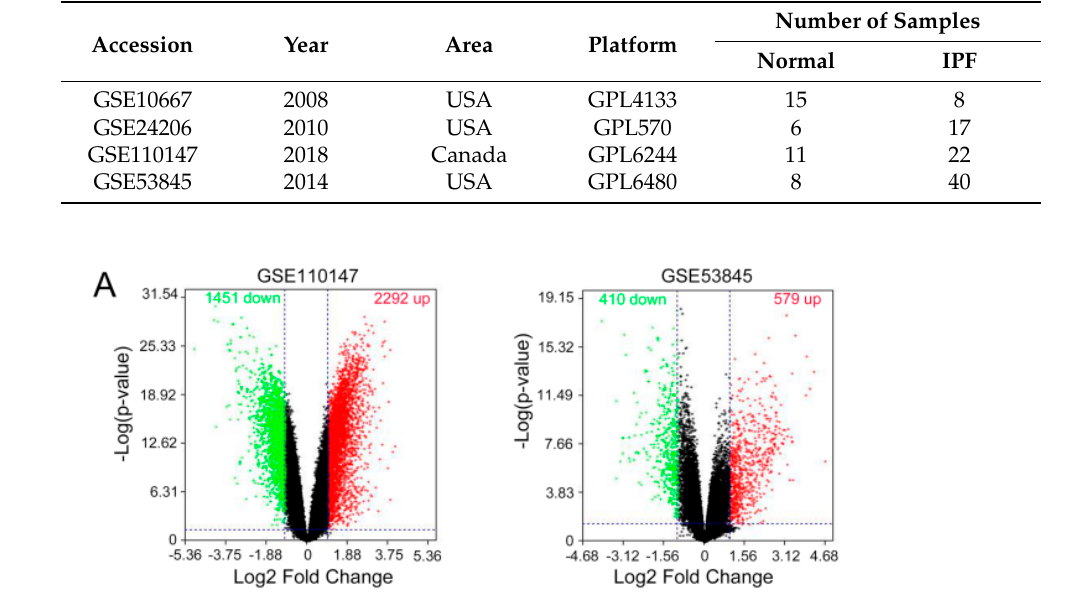
Table 1. Details about the datasets used in this study.